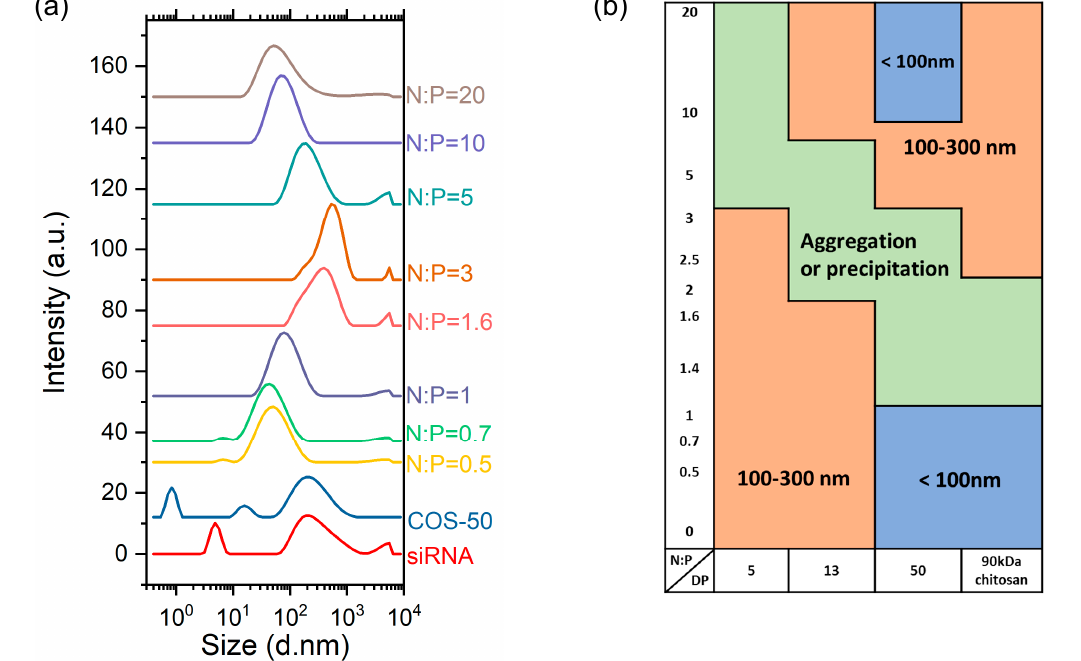
Figure 5. (a ) The intensity-average particle size distributions of COS-50/siRNA complexes in RNase-free water by DLS with a 173° angle detection at various N:P ratios using a siRNA concentration of 0.1 g/L. ( b ) The particle size map representing the typical values of hydrodynamic diameter (D H ) of complexes obtained at various N:P ratios with COS varying in DP and parent chitosan (90 kDa). Efficiency of the complexation. The binding affinity of polyion to siRNA was determined by a direct titration of free siRNA in the complexation medium at various N:P ratios. This approach has been preferred to indirect methods, like the dye exclusion assay with ethidium bromide (EtBr), since the exclusion mechanism of the intercalated dye from siRNA (or DNA) is not completely known. In particular, it cannot be assumed that the dye displacement is stoichiometric with respect to the added